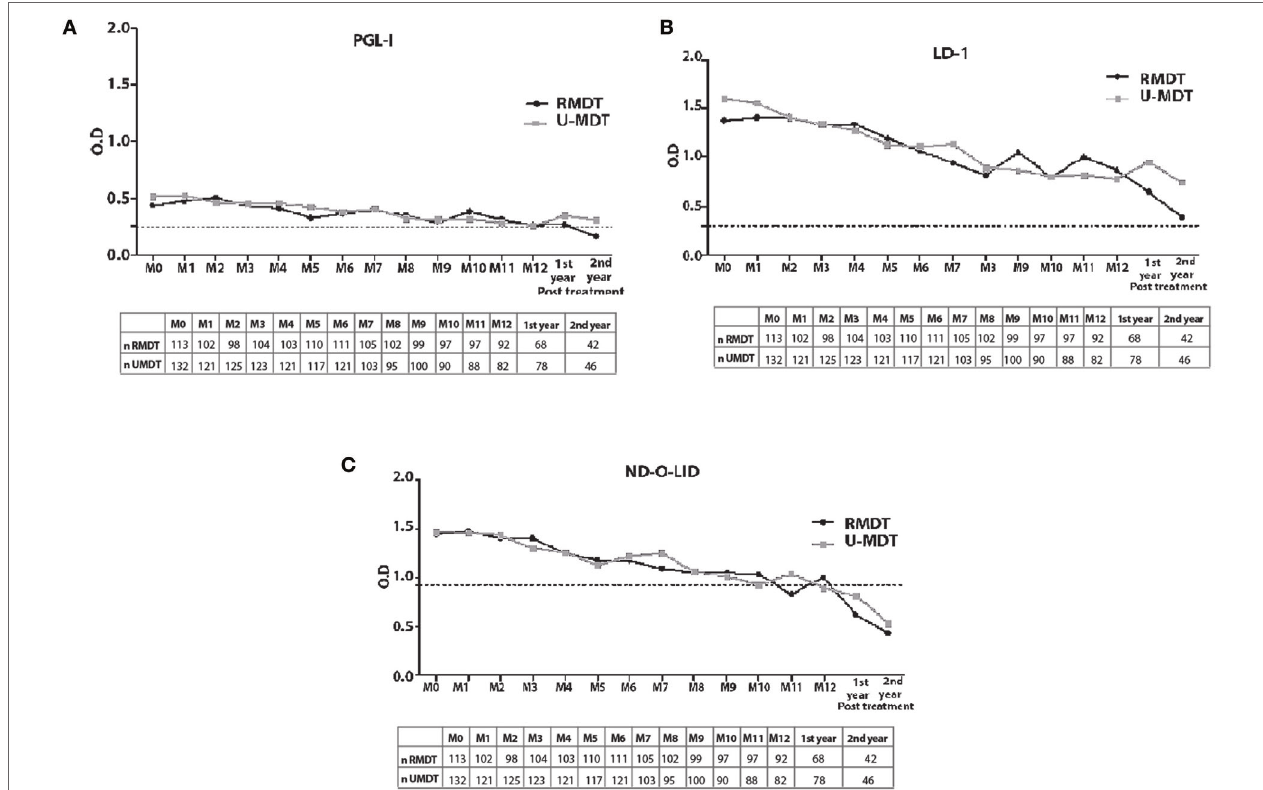
FigUre 1 | Kinetic of Mycobacterium leprae -specific antibody responses in multibacillary treated with regular multidrug therapy (R-MDT) (closed black circles) and uniform multidrug therapy (U-MDT) (gray closed squares) from baseline month zero (M0) to month 12 (M12) after starting treatment, and after the first and second year of treatment conclusion. (a) Anti-phenollic glycolipid-I antigen serology; (B) anti-LID-1 serology; (c) anti-ND-O-LID serology. Each point represents the median optical density (OD) value of each group. The dotted horizontal lines indicate cutoff points of each serological test.